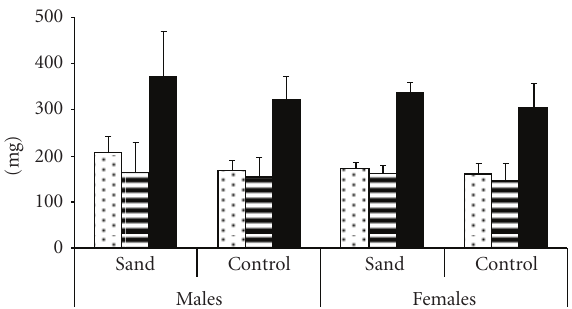
Figure 2: Mass (mg, mean + SD) of left (spotted bars) and right (lined bars) adrenal and total mass of adrenals (black bars) of juvenile blue foxes in the Sand and Control groups. Main e ff ects (GLM for repeated measures): Left adrenal Group F (1,13) = 7 . 70, P = . 016, Sex F (1,13) = 5 . 88, P = . 031, Sex ∗ Group F (1,13) = 2 . 30, NS; Right adrenal Group F (1,13) = 0 . 70, NS, Sex F (1,13) = 0 . 14, NS, Sex ∗ Group F (1,13) = 0 . 06, NS; Total mass of adrenals Group F (1,13) = 2 . 97, NS, Sex F (1,13) = 1 . 52, NS, Sex ∗ Group F (1,13) = 0 . 17,